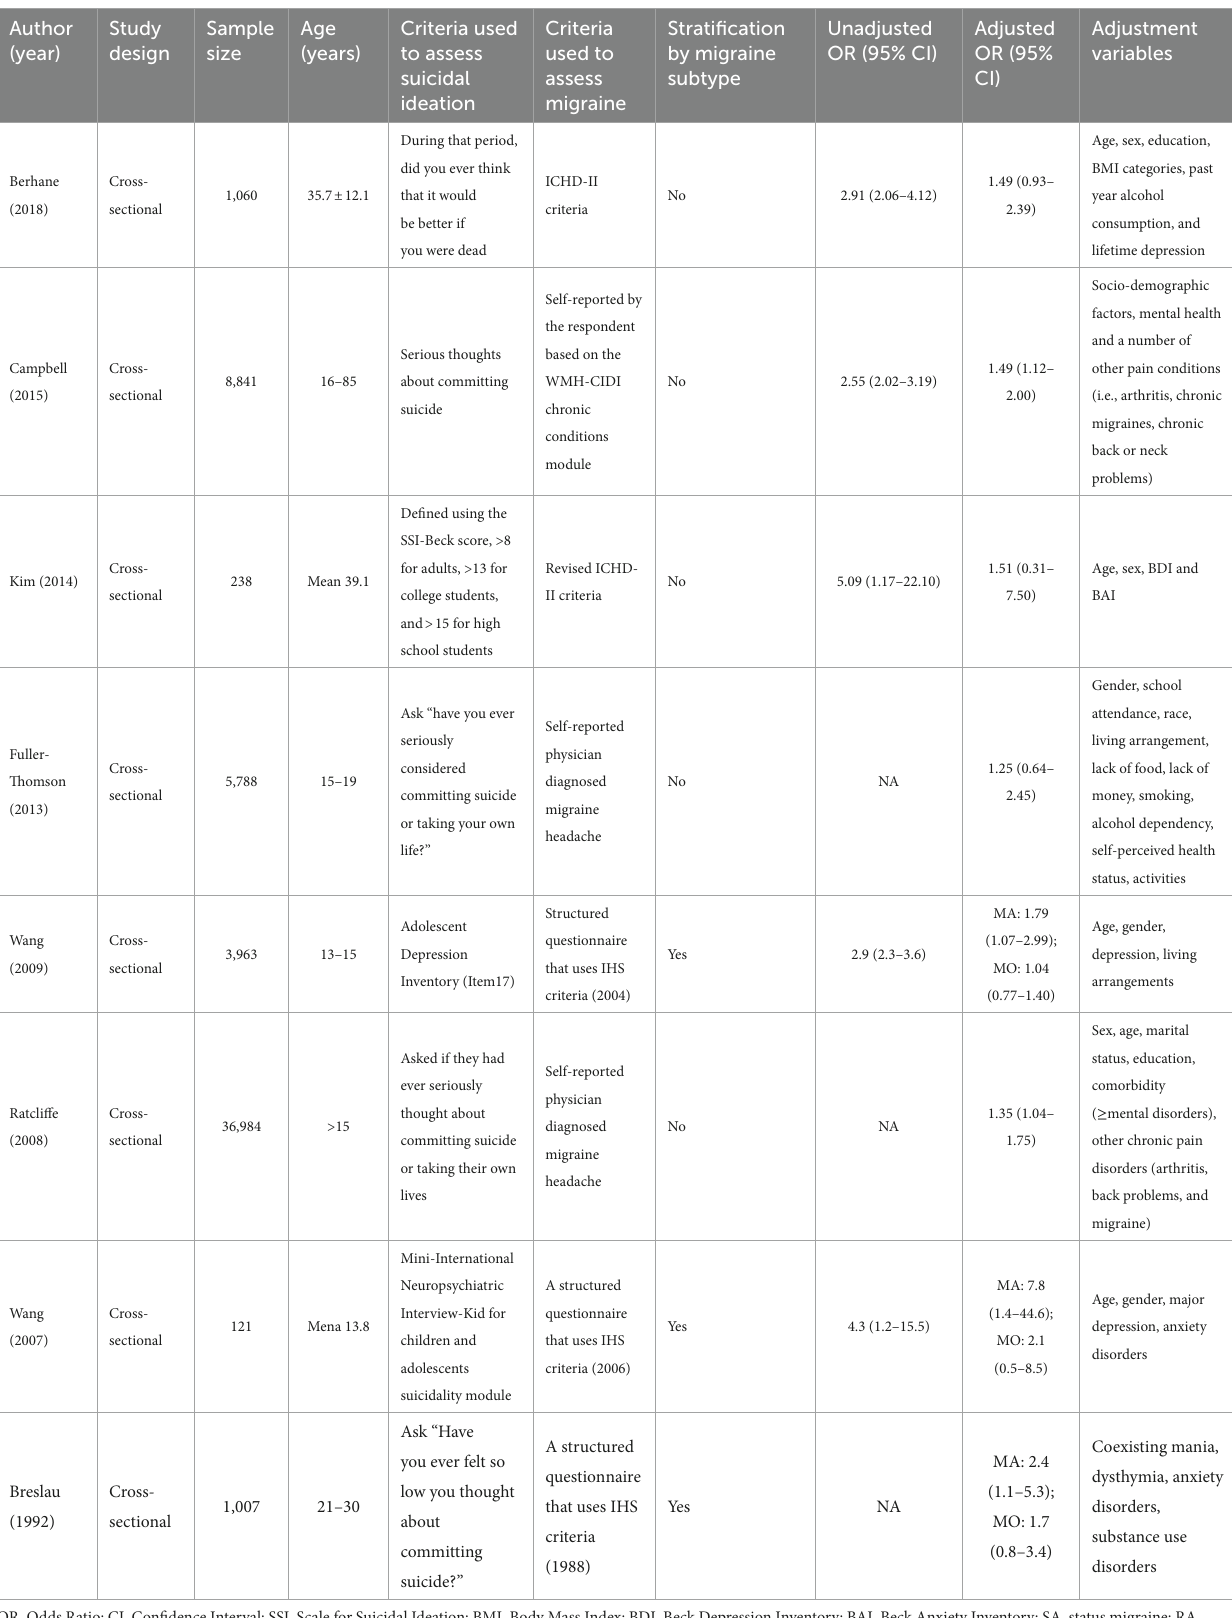
TABLE 1 Description of studies about suicidal ideation and migraine included in the